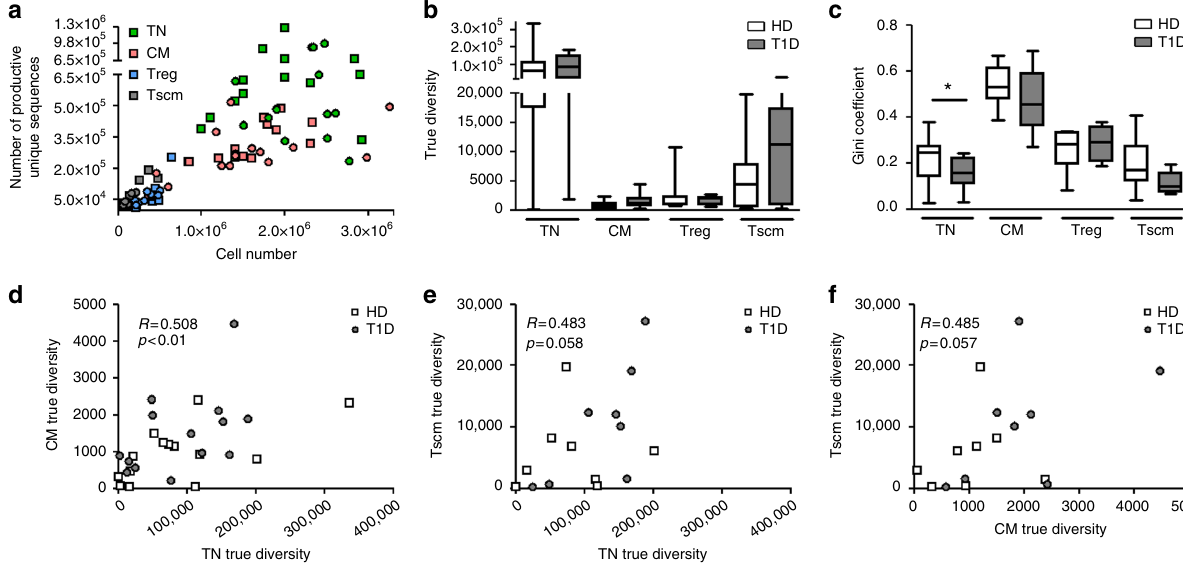
Fig. 1 Diversity and clonality indices of TCRB repertoire of CD4 + T cells. a The number of productive unique sequences (unique clonotypes) correlates with the cell number (Spearman's R = 0.85. p < 0.0001). b , c Sequencing data were normalized and true diversity indices b and Gini coef fi cients c were calculated (Methods section). TN cells from patients are less clonal than TN cells from healthy donors (Mann – Whitney U -test). Species is de fi ned as a unique nucleotide sequence. d – f True diversity indices positively correlate among the TN, CM and Tscm cell subsets, consistent with CM and Tscm propagating from TN (Pearson's correlation). TN, true naive cells; CM, central memory cells; Treg, regulatory T cells; Tscm, stem